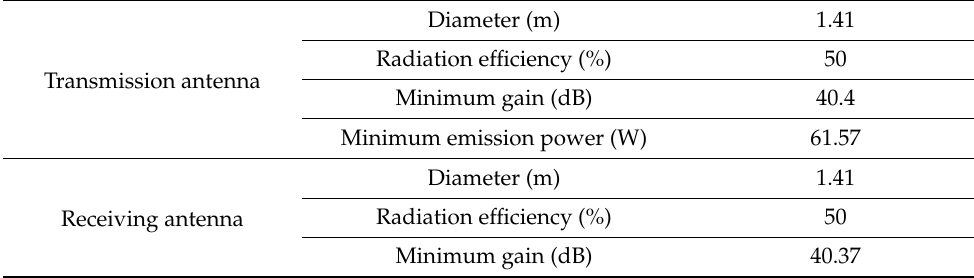
Table 12. Simulated satellite project link budget